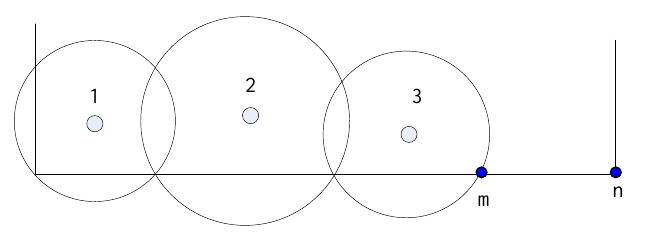
Figure 7. Illustration of border communication void